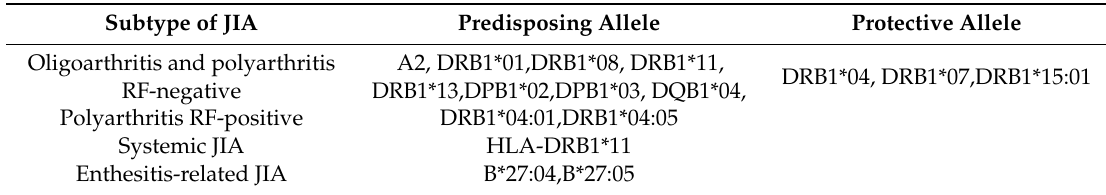
Table 2. HLA alleles associated with JIA